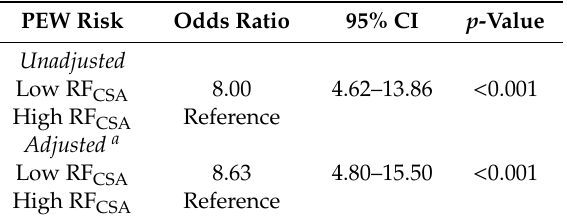
Table 6. Association of the RF CSA gender-specific values with PEW